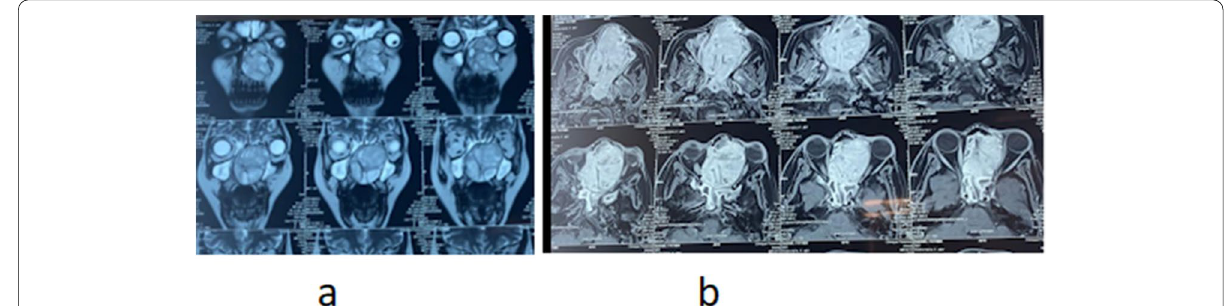
Fig. 2 Radiological findings in MRI. a Radiological findings of coronal sections. b Radiological findings of axial